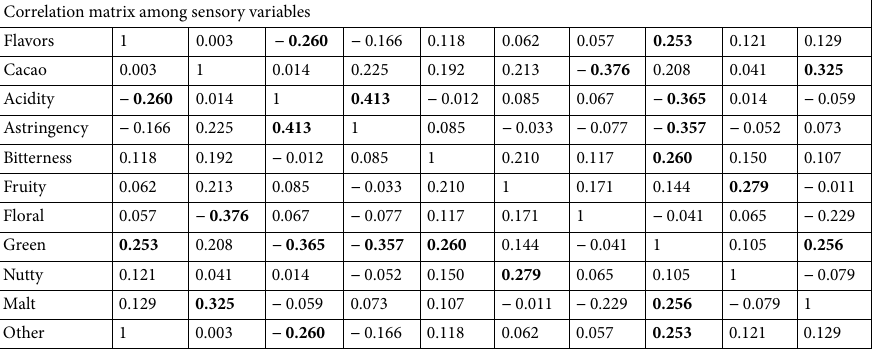
Table 1. Spearman correlation among sensory variables. In bold, significant values (P < 0.05). Other: refers mainly to the over-fermented